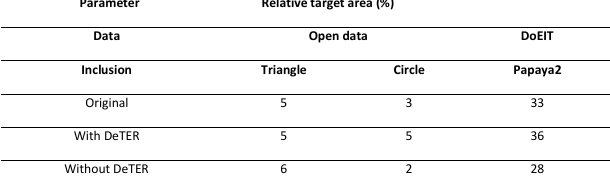
Table 2: Improvement in relative target area